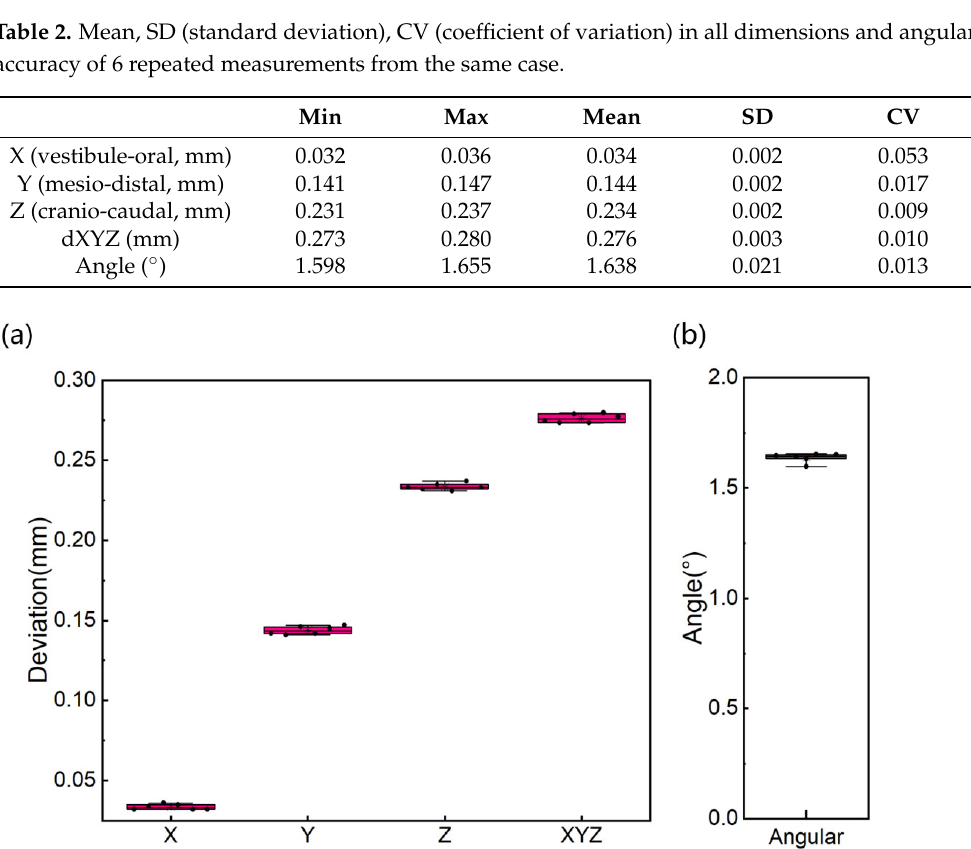
Figure 3. Deviation boxplots on all dimensions ( a ) and angular displacement ( b ) of the same case for 6 repeated measurements.